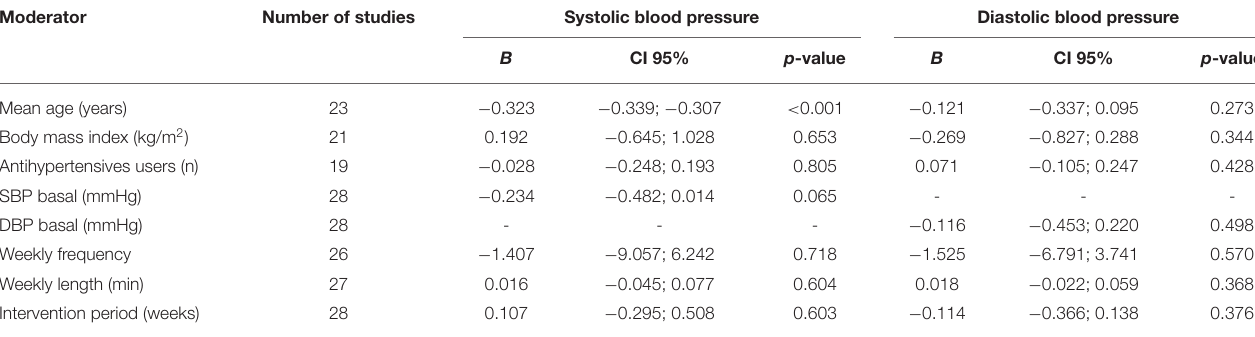
TABLE 5 | Meta-regression